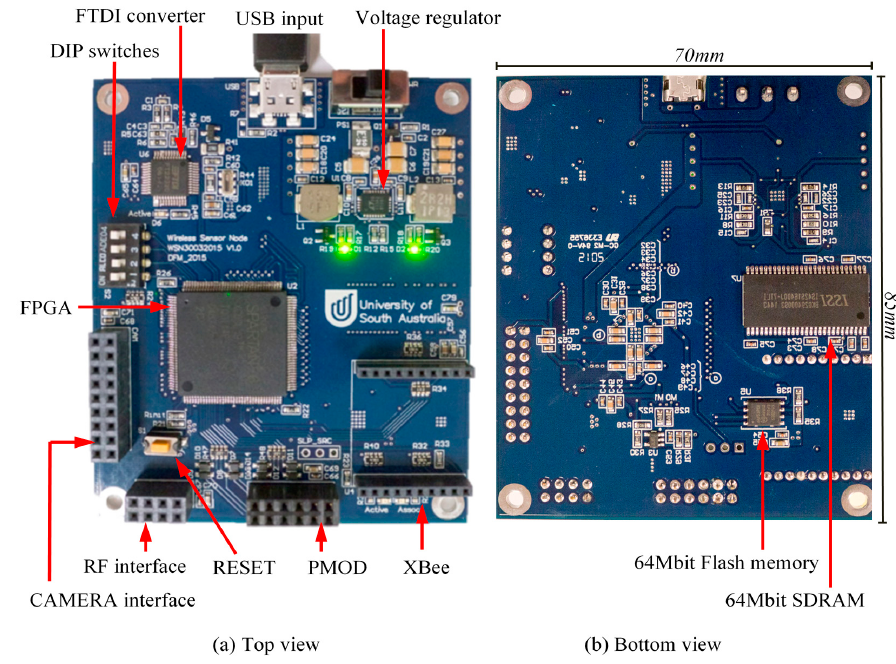
Figure 2. FPGA-based Wireless Sensor Node—dimensions 70 mm × 85 mm.